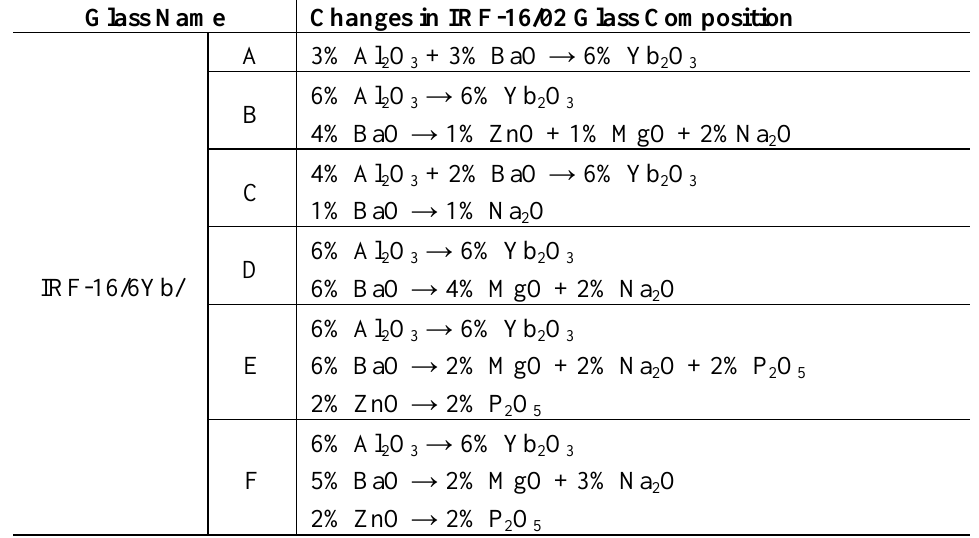
Table 3. The chemical composition of the IRF-16/6Yb/A-F series glasses compared with the base composition of IRF-16/02 glass (mol%).